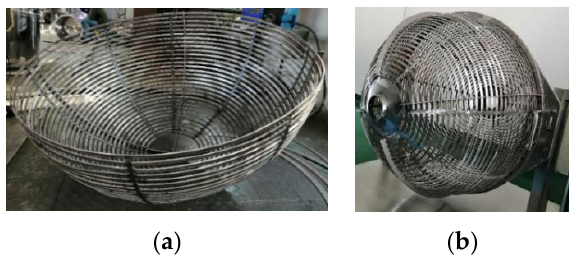
Figure 8. The finished powersphere frame: ( a ) the hemisphere frame, ( b ) the ball frame. During the manufacturing experiment, because the thickness of the iron ring is too large, the number of 1/4-round workpieces is not enough, and the arc of the iron ring between two 1/4-round workpieces is not round enough, as shown in Figure 9. This requires manual adjustment of the roundness of the iron ring, which causes processing errors and affects the light uniformity of the powersphere. In the future manufacturing, some measures can be taken to reduce the error, such as reducing the thickness of the material, increasing the number of 1/4-round workpieces, and dividing the iron ring into multiple short arc-shaped workpieces followed by welding. In the manufacturing experiment, another problem is that the welding positions of the small iron bars are not accurate, which will affect the installation accuracy of the photovoltaic cells. It is found that such processing errors can be reduced by adjusting the processing sequence. Before the iron plate is bent into an iron ring, a small iron bar is welded to the iron plate and then bent together to form a ring. In this way, it is easy to weld small iron bars on the flat plate, which reduces the technical requirements. After the spherical frame is manufactured, in order to install the photovoltaic cells between the adjacent small iron bars, a two-component acrylic fast curing structural adhesive is used to bond the photovoltaic cells and the spherical frame. This adhesive can be used to bond the metal iron spherical frame with the glass material photovoltaic cells, and quickly cure to achieve a high bonding strength. The high-temperature resistance of the adhesive is also very important for the application of the powersphere. During the bonding process, the thickness of the adhesive was also adjusted to fine-tune the installation of the photovoltaic cells. The manufacturing results are shown in Figure